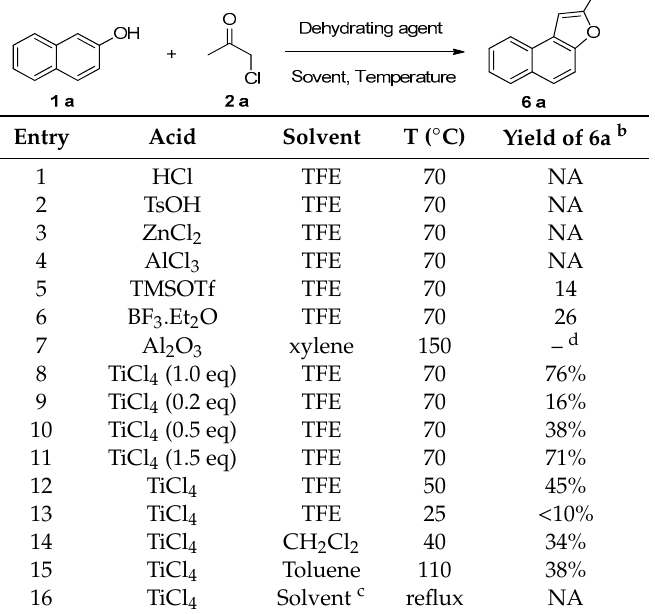
Table 1. Model reaction optimization a .